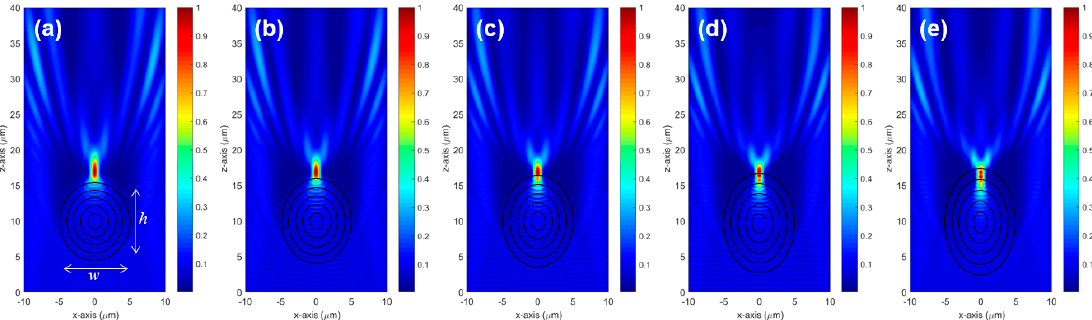
Figure 8. Intensity distributions of the elliptical shape Luneburg lens of the ELS profile with N = 5: ( a ) the aspect ratio A = 1.1, ( b ) 1.2, ( c ) 1.3, ( d ) 1.4, and ( e ) 1.5, respectively. The intensities are normalized. Concentric ellipses depict the step boundary of the index profile.